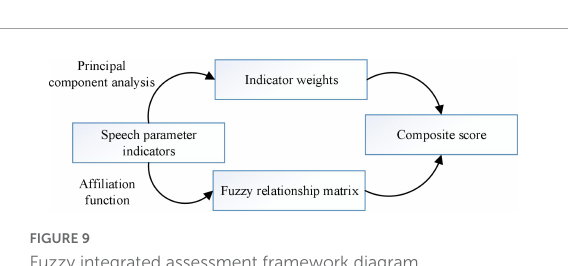
FIGURE9 Fuzzy integrated assessment framework diagram.